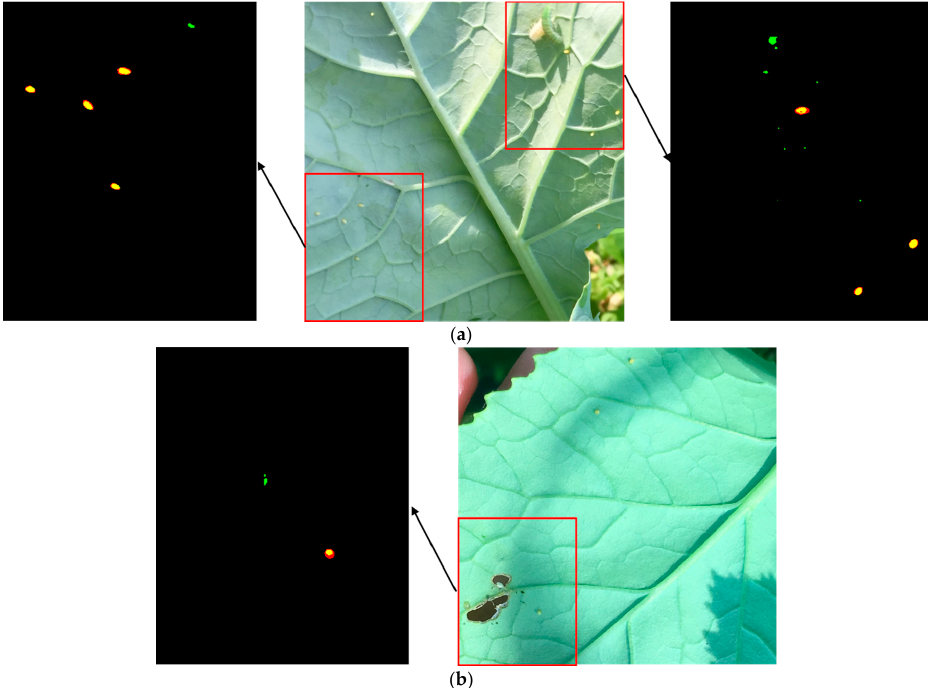
Figure 5. Images captured in field and corresponding segmentation results. ( a ) A leaf image taken under complex lighting conditions. Segmentations of two regions with different lighting are shown in detail. ( b ) An image of an injured leaf. Segmentation of a region around lesions is shown in detail.